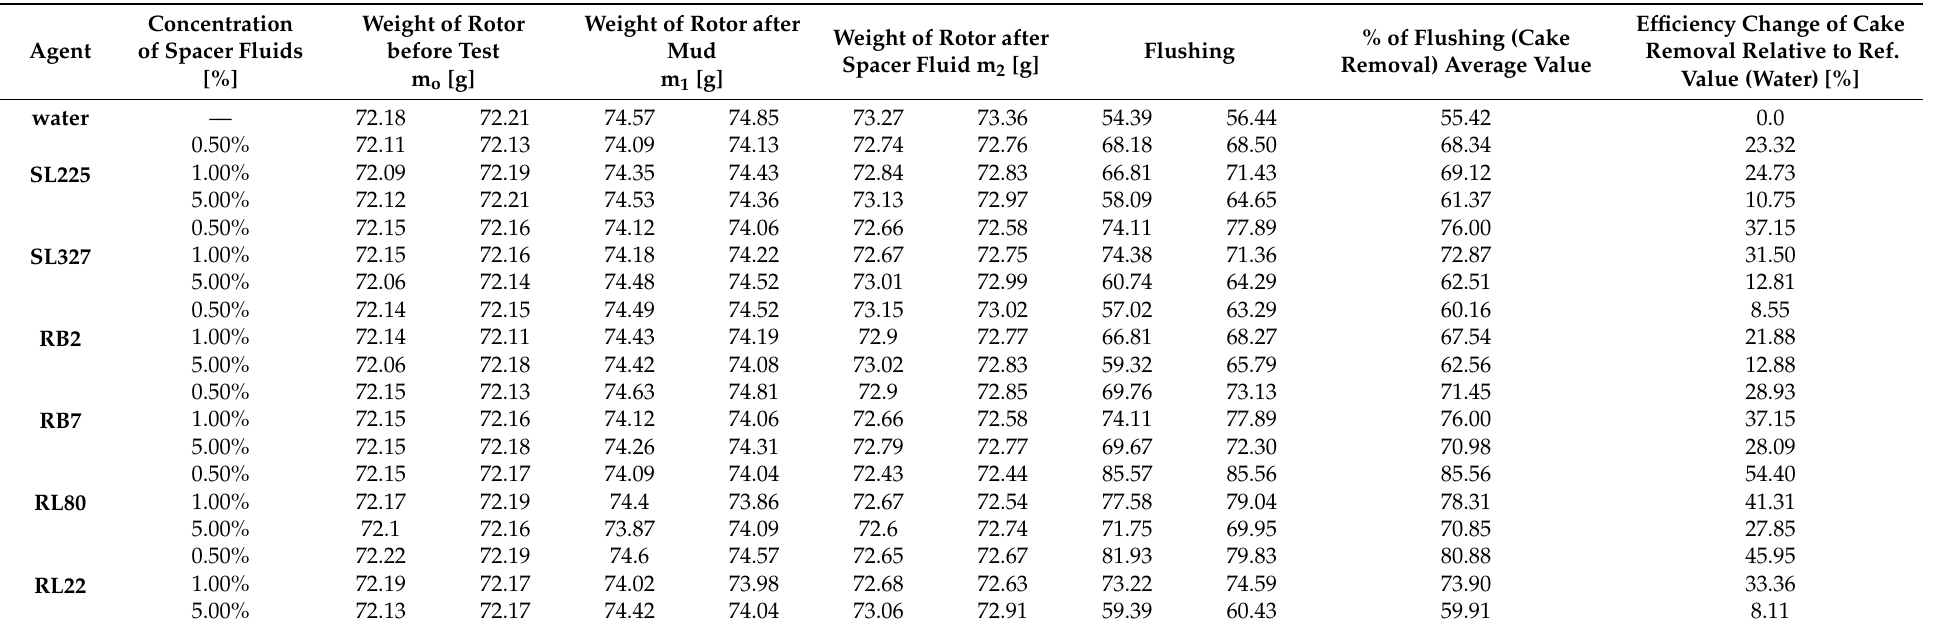
Table 2. Efficiency of mud cake removal from the rotor’s surface with new